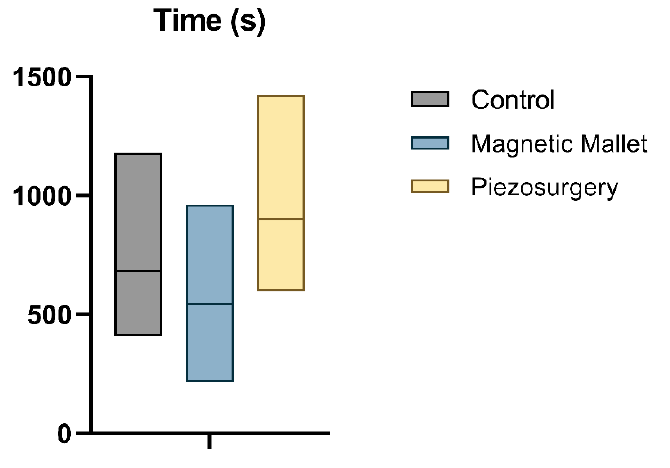
Figure 5. Box plot of time.